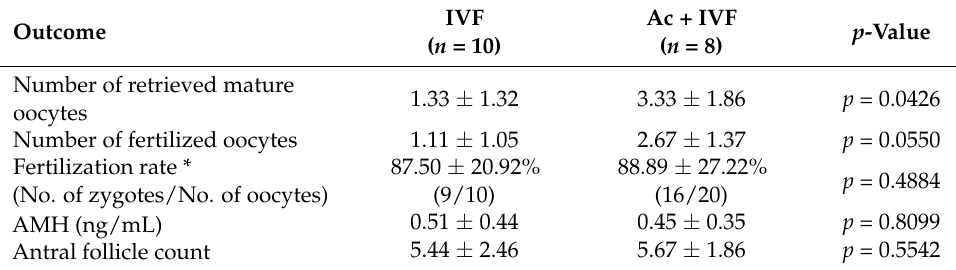
Table 6. Comparison of clinical outcomes of patients aged >37 years in the two study groups. Outcome Number of retrieved